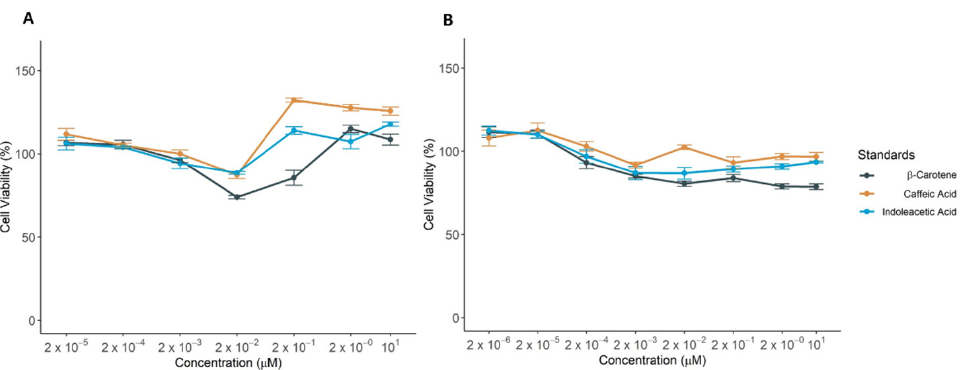
Figure 3. Detection cell viability of HEK-293 ( A ) and MDCK ( B ) incubated with increasing amount of indoleacetic acid, β -carotene and caffeic acid for 24 ( B ) or 72 h ( A ). Reported values correspond to mean of cell viability with standard error over three biological replicates. The percentage of cell viability was calculated using the ratio Abs TEST /Abs CTRL .